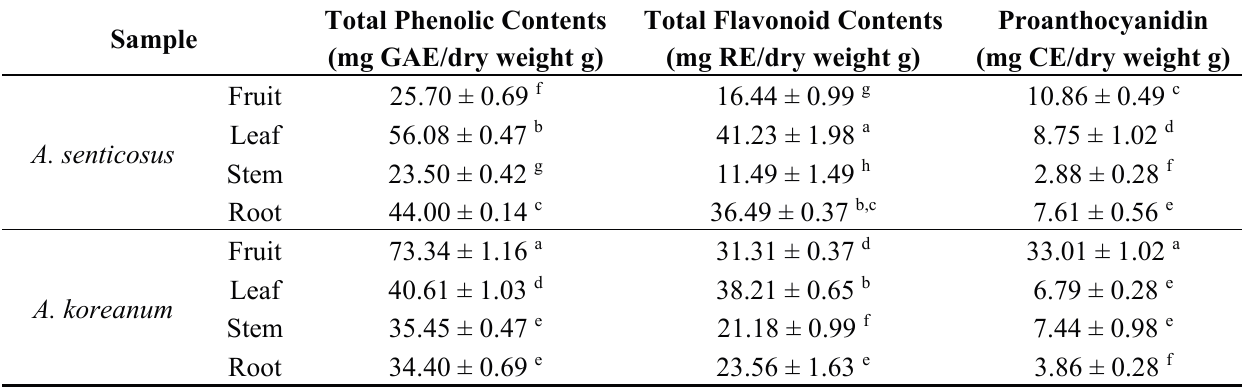
Table 1. Total phenolic, total flavonoid and proanthocyanidin contents in the different parts of A. senticosus and A.